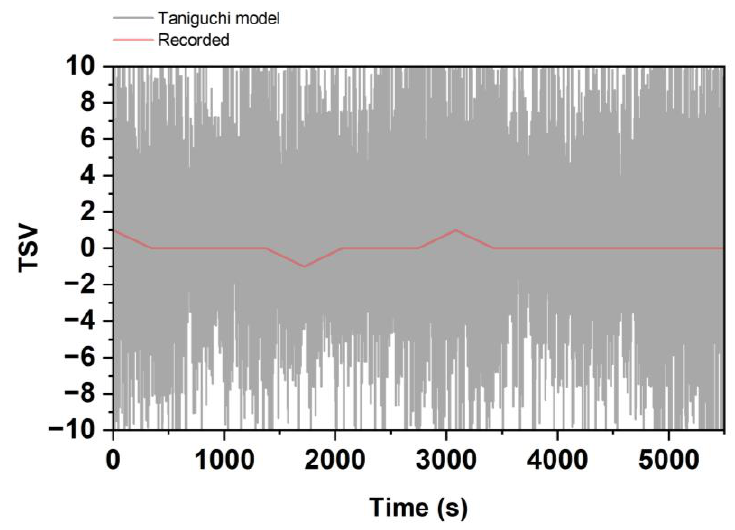
Figure A1. Feature creation using wavelet decomposition.